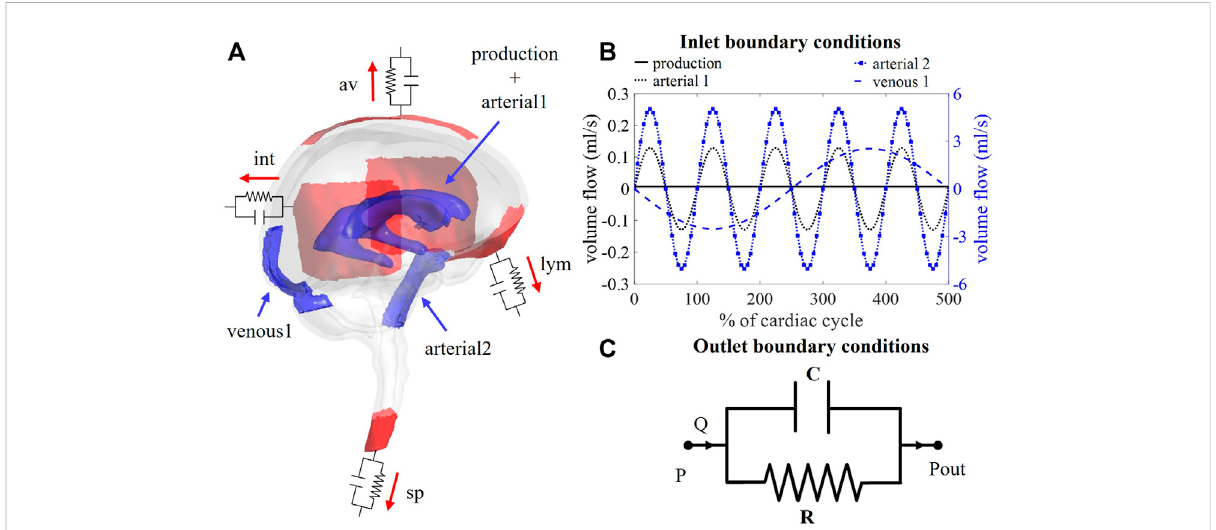
FIGURE 1 (A) Visualization of boundary conditions in the 3D model. Production and arterial1 designate the surface of the lateral ventricles (in blue), while arterial2 and venous1 point at the CSF volumes around the basilar artery and the cervical cerebral veins, respectively (in blue). The four outlet boundaryconditionsaredesignatedinredandcorrespondtotheinterstitium(int),spinal(sp),lymphatic(lym),andarachnoidvilli(av)outlet. (B) Graph containing the waveforms of the four different inlet boundary conditions depicted in (A) . (C) Electrical circuit representing the 2-element windkessel model, which is imposed at the outlets, containing a resistance R and compliance C in parallel. A pressure difference P – P out is created when a fl ow Q passes through the